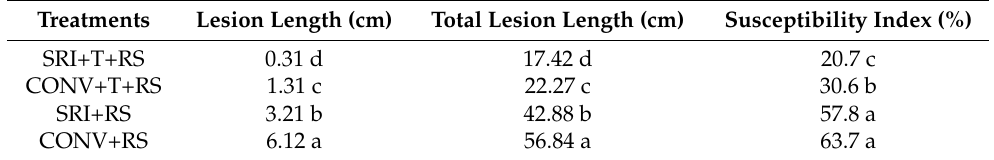
Table 5. Effects of T. asperellum SL2 and SRI methods for protecting rice plants from R. solani infection.